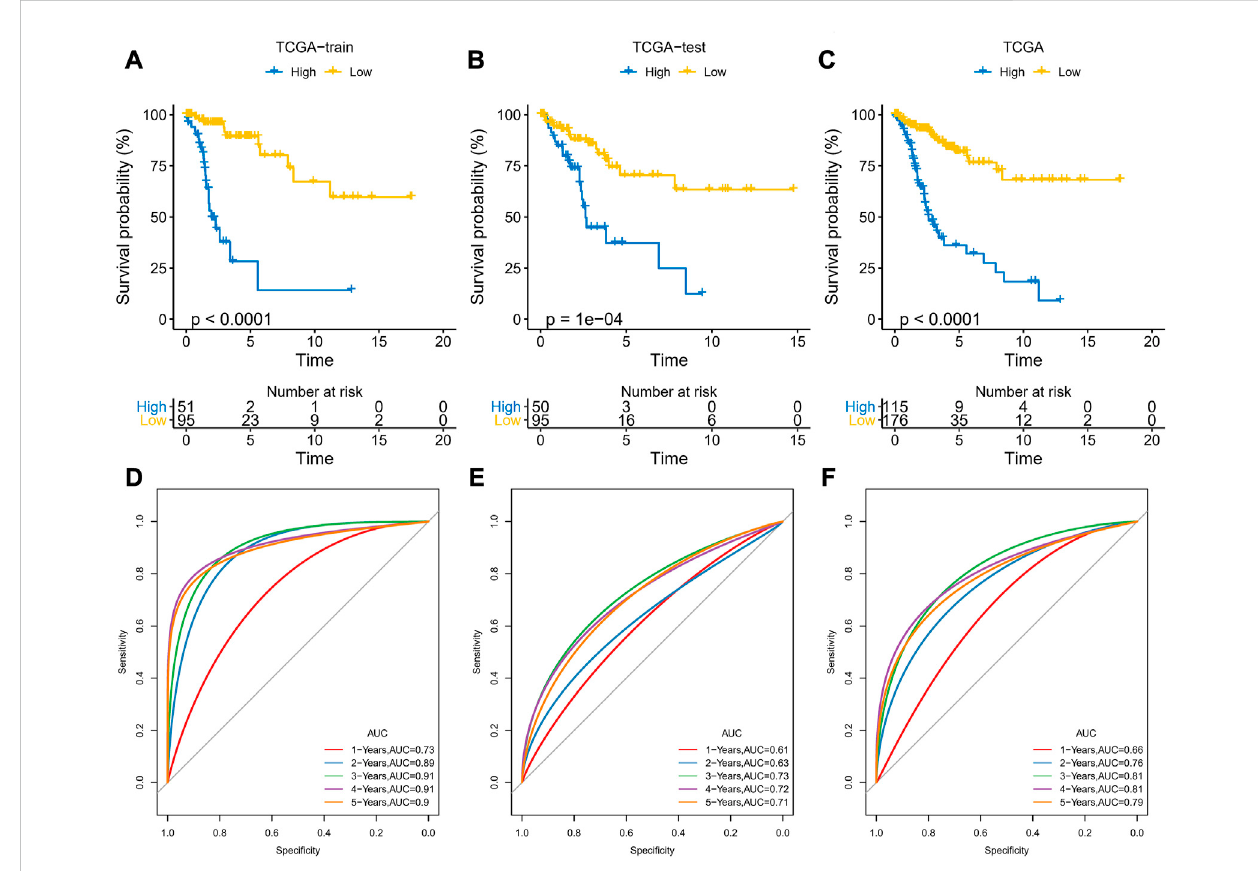
FIGURE 6 Development and validation of APR_Score (A – C) K-M curves for the 7 ARLs in the training set, validation set and TCGA-CESC cohort (D – F) ROC curves of the training set, validation set and TCGA-CESC